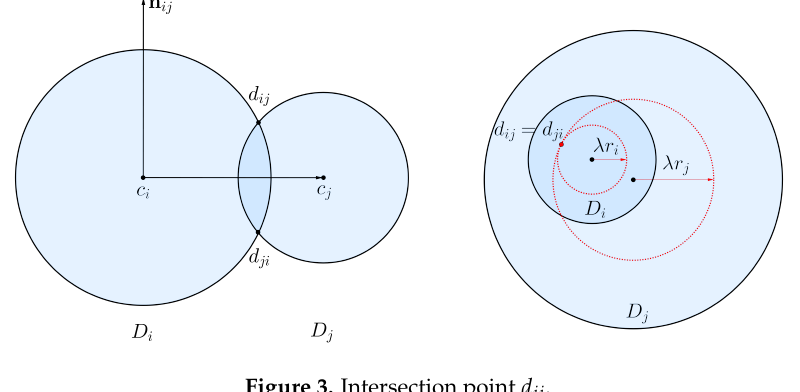
Figure 3. Intersection point d ij